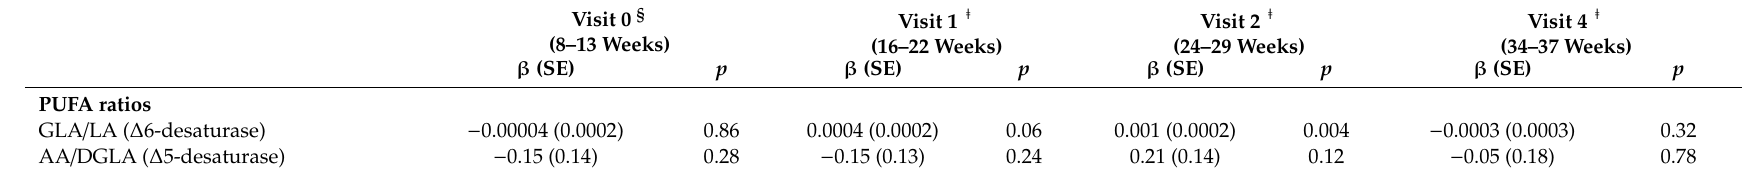
Table 2. Time-specific associations of maternal moderate-to-vigorous physical activity (MVPA) and plasma phospholipid polyunsaturated fatty acids (PUFAs) at each study visits in the NICHD Fetal Growth Studies–Singleton